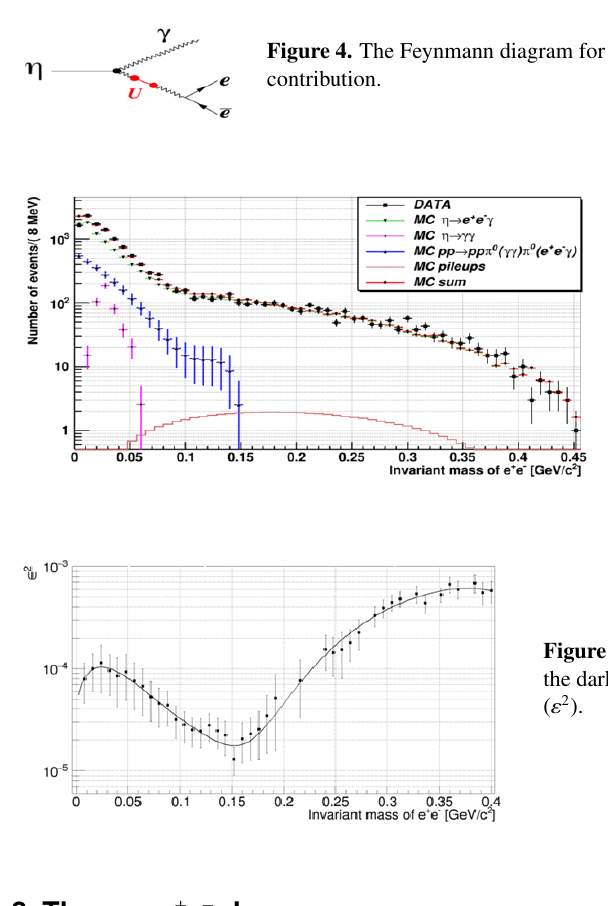
Figure 4. The Feynmann diagram for the η → e + e − γ : dark photon contribution.